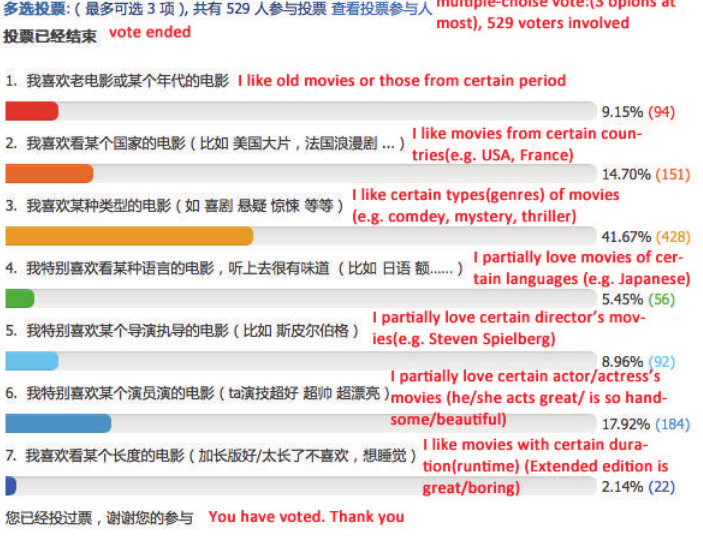
Figure 3: Survey in our community.